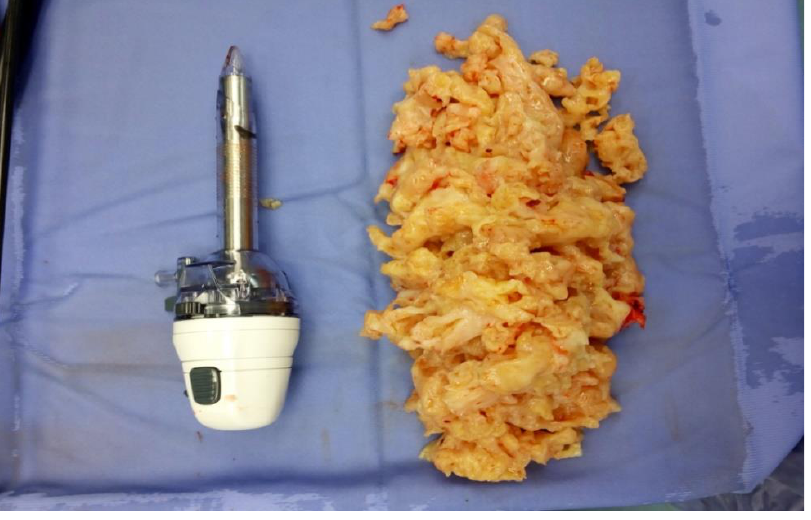
Figure 2. The morcellated uterine fibroid.